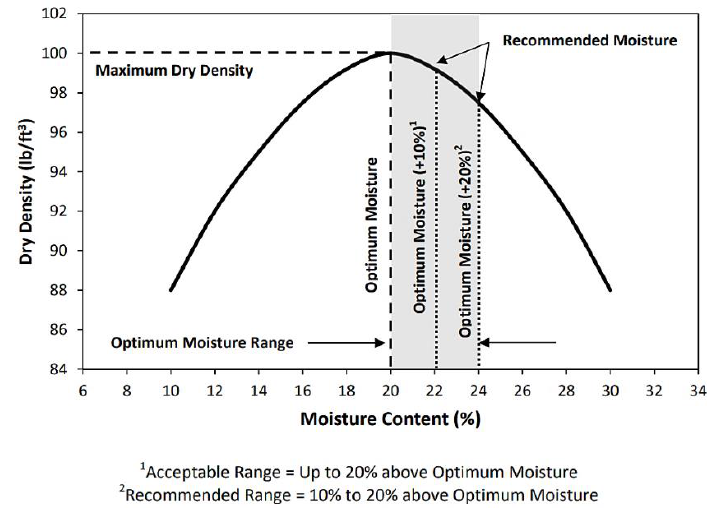
Figure 5. Moisture content control chart (Section 3/9 of